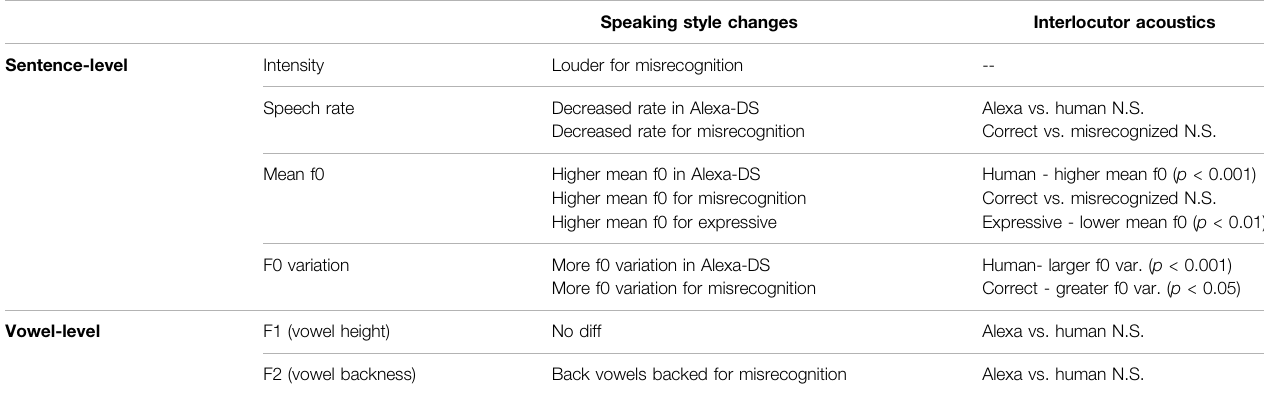
TABLE 2 | Summary of effects in main analysis, comparing interlocutor